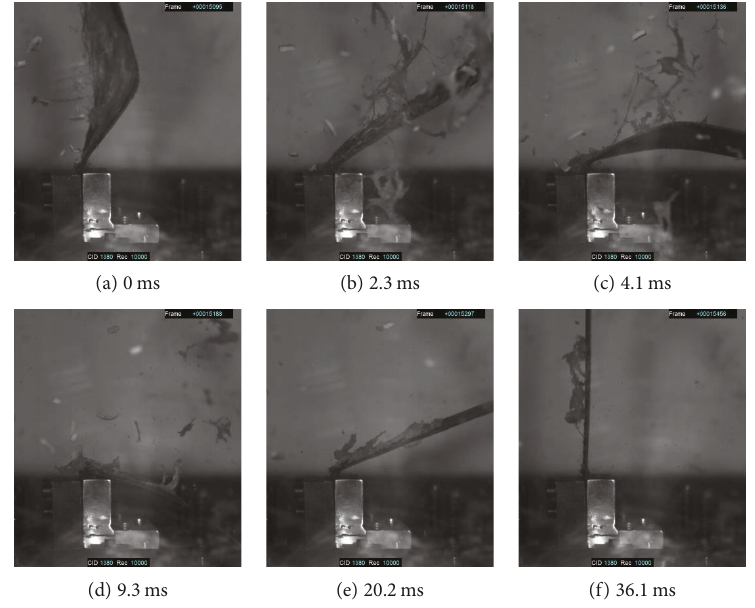
Figure 15: Bending de fl ection process of 30 ° braiding composite target.